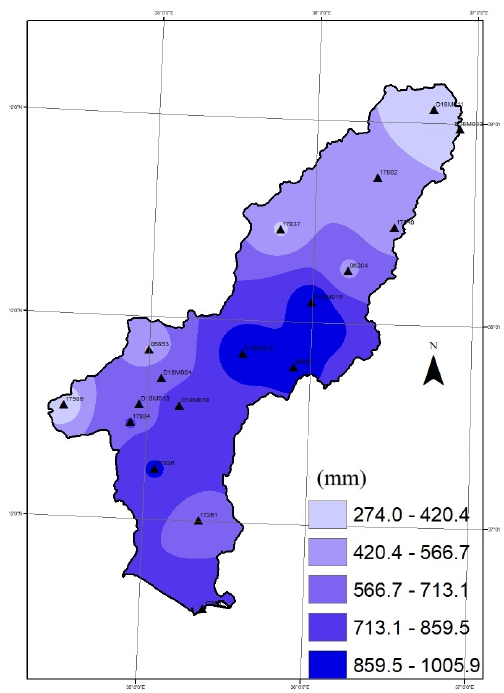
Figure 3. Spatial change in the annual precipitation over the Seyhan River basin.